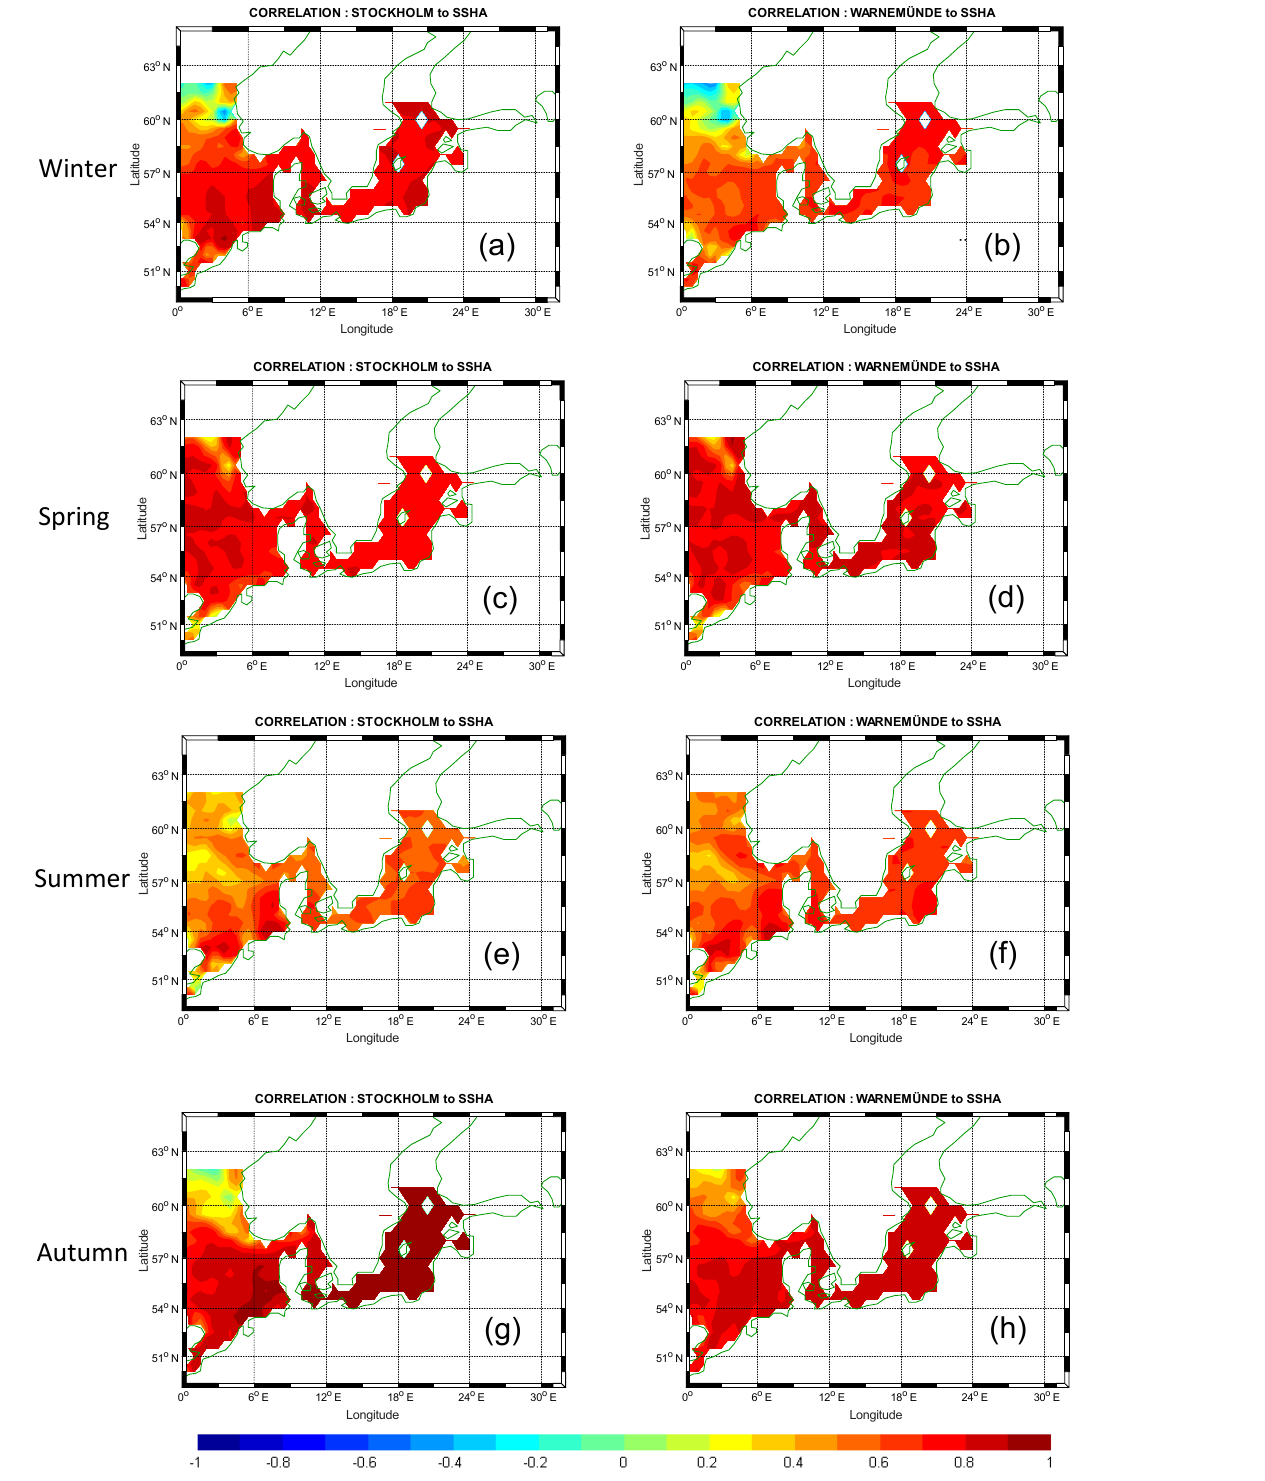
Figure 4. Correlations of decadal gliding trends between selected (Stockholm a, c, e, g and Warnemünde b, d, f, h ) tide gauges and SSHA grids for all seasons shown in the order of winter ( a and b ), spring ( c and d ), summer ( e and f ), and autumn ( g and h ) for the period 1950–2008. The 95% significance level is ± 0.25 for this record